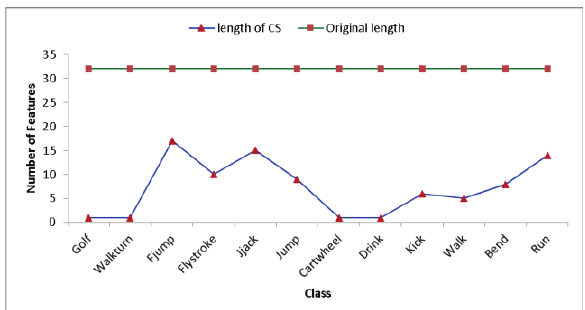
Fig. 2. The relative length of the discovered contrast sets from the 3D mocap action dataset to the length of the original feature vector.